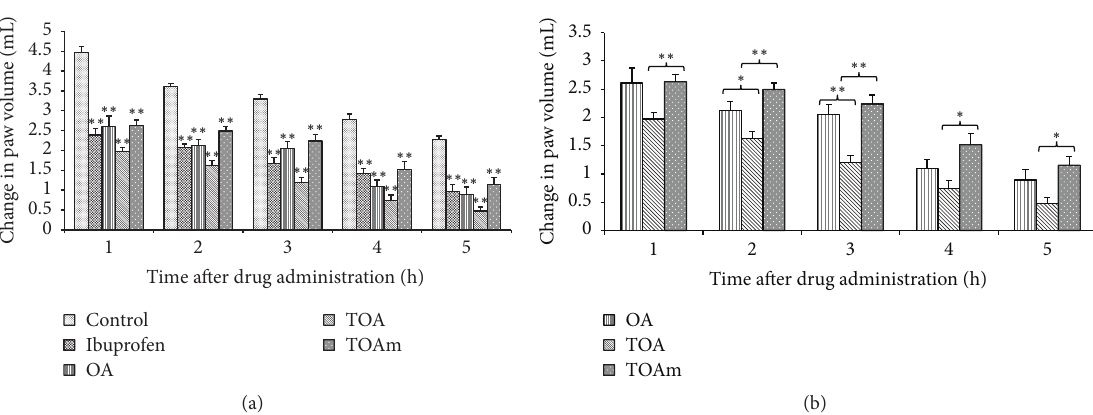
Figure 7: Anti-inflammatory effect of the trifluoroacetyl derivatives of OA. Results are expressed as mean change in paw volume ± SEM for 6 animals; ∗ 𝑝 < 0.05 and ∗∗ 𝑝 < 0.01 . (a) shows a comparison of the tested compounds with control group, whereas (b) shows the comparison of anti-inflammatory effects of the trifluoroacetyl derivatives of OA with